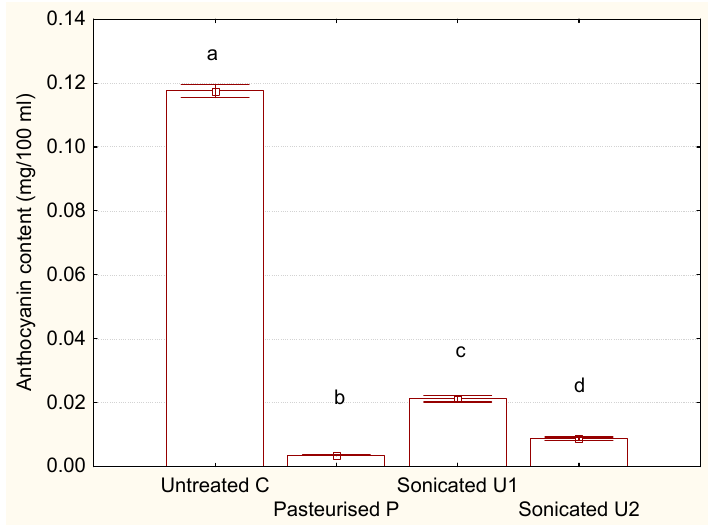
Figure 8. Effect of preservation method on anthocyanin content in apple juice. Error bars represent standard deviations. Values that share the same letter are not significantly different at P < 0.05.